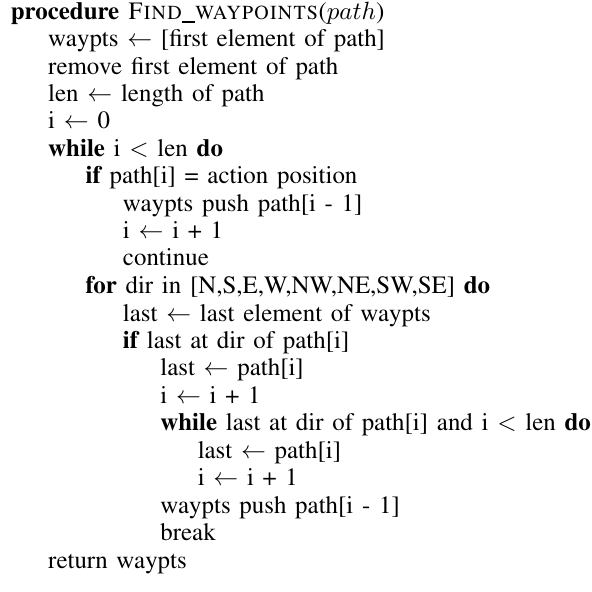
Fig. 9. Find lines among the points and remove the intermediary points, keeping only the points where the agent must turn or execute a non-movement